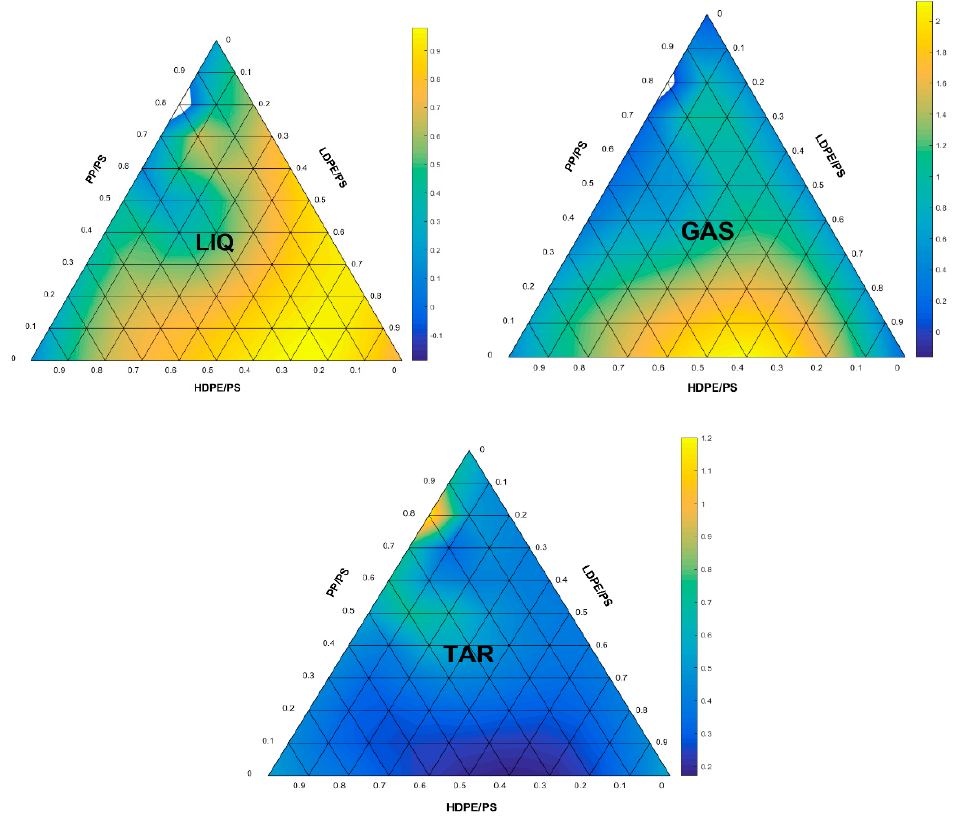
Figure 9. Prediction of liquid, gas, and tar yield based on the plastic composition.